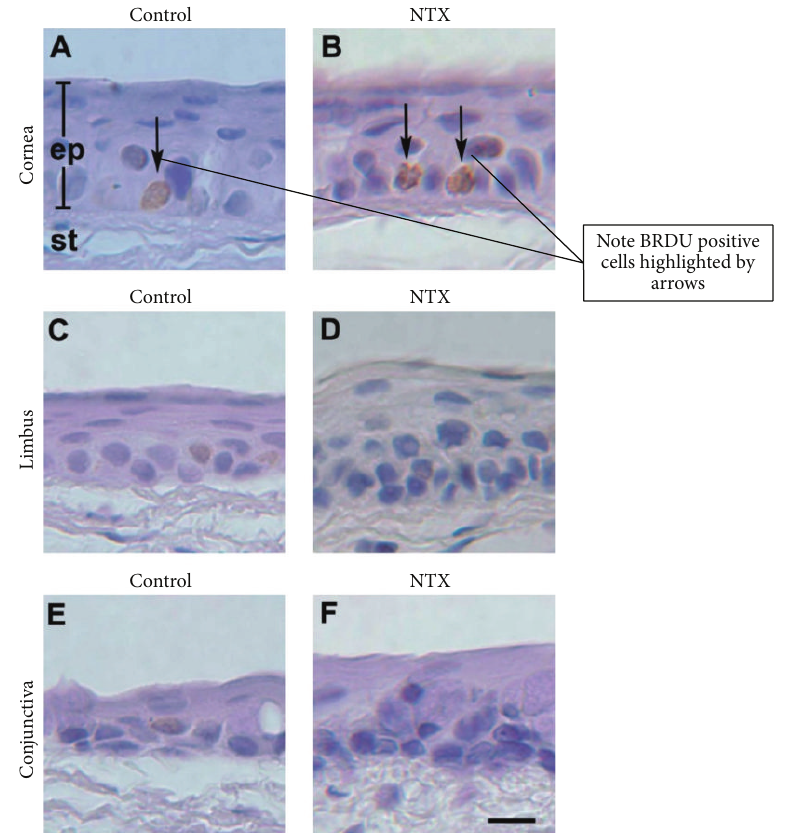
Figure 8: Impact of chronic NTX on homeostatic corneal epithelium. Seven-day treatment with systemic NTX. Rate of DNA synthesis determined using BrdU. Arrows are BrdU-positive, DNA synthetic cells. DNA synthetic cells increased by 69–85% following NTX treatment. Epithelial thickness increased by 8 to 38%. There was increased packing density. Nevertheless, no toxicity or proliferative pathology was seen. Rather, NTX treatment accelerates normal homeostatic processes, but there is negligible apoptosis or necrosis. st: stroma; ep: epithelium. Bar = 12 𝜇 m (derived from